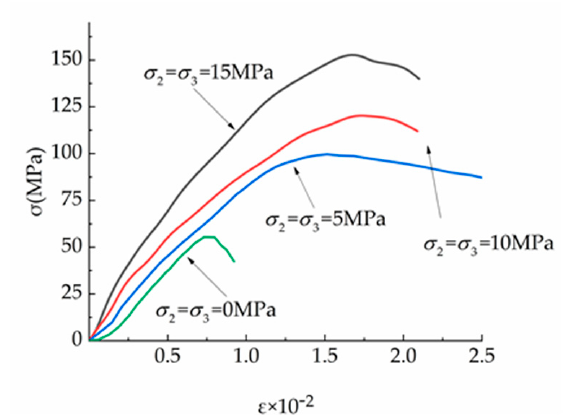
Figure 13. Stress-strain curve of SCC.